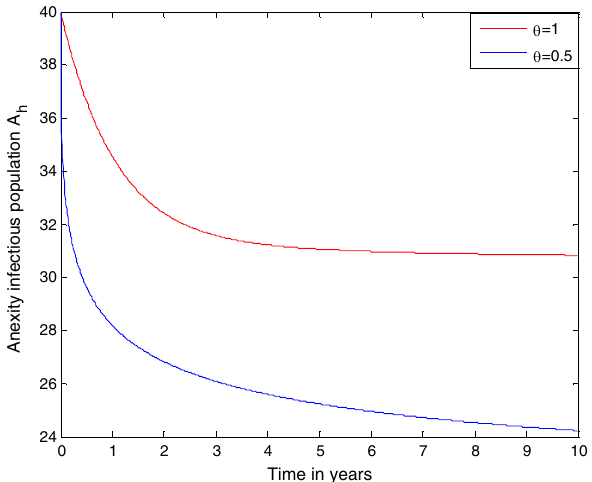
Figure 7. Order of derivative( memory) effects on anxiety infectious population A h .